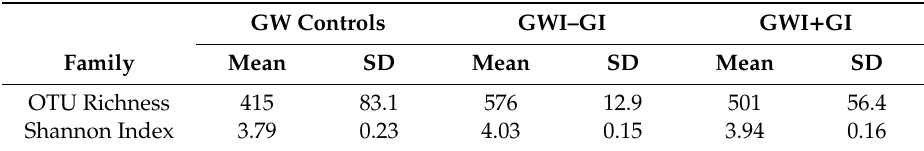
Table 3. Sample Diversity Results by Groups.